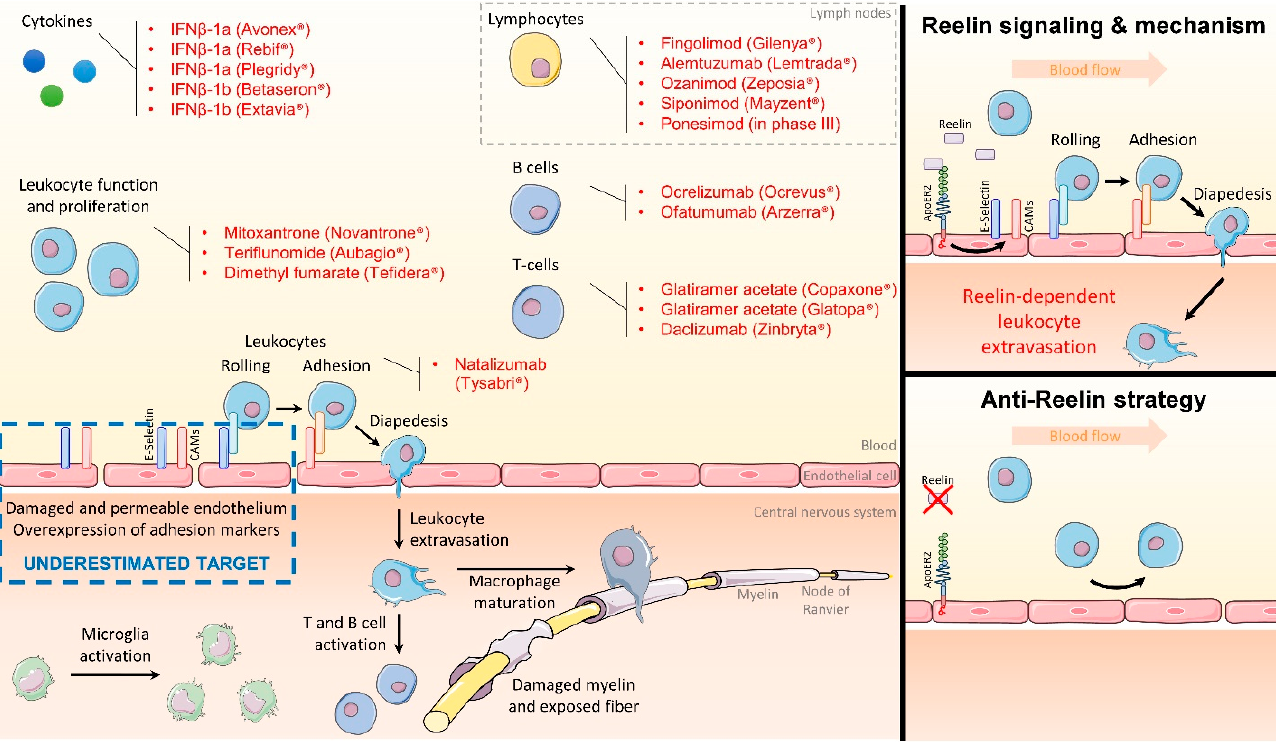
Figure 1. MS therapeutic targets and therapeutic opportunities. The left panel lists the presently used MS drugs that target the immune system while therapeutic opportunities of targeting the blood–brain barrier appear undervalued. The right panels illustrate how plasma Reelin controls the expression of endothelial adhesion proteins via activation of its receptor ApoER2, which induces NF- κ B